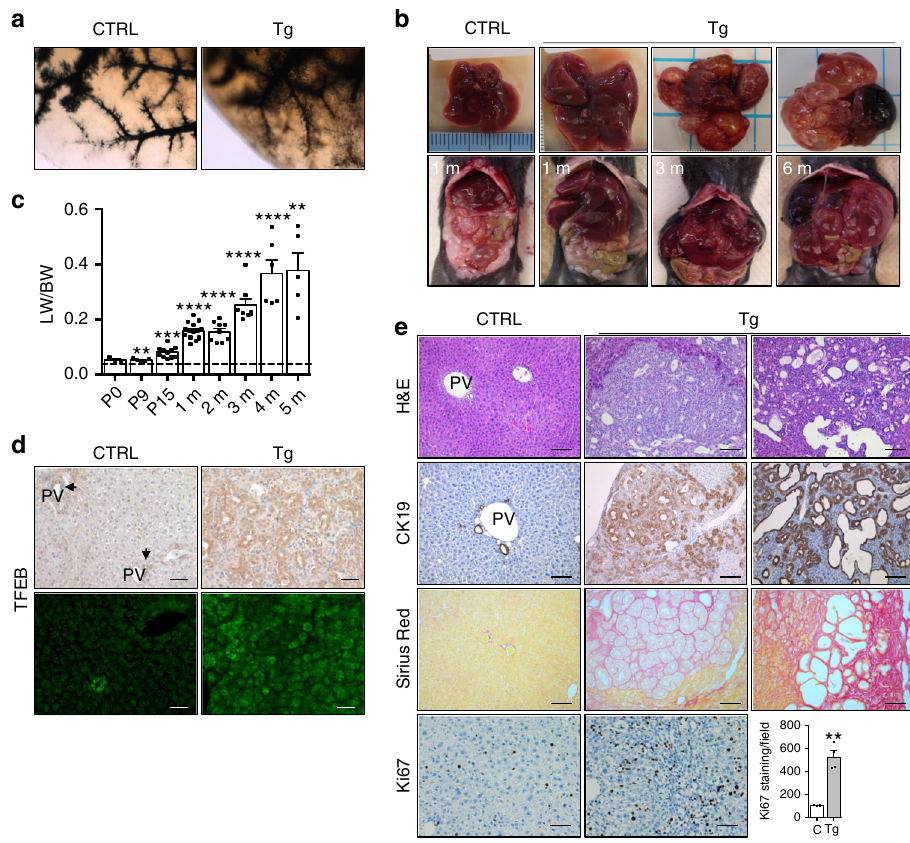
Fig. 8 Bile duct neoplasm in TFEB-overexpressing liver. a Retrograde injection of ink revealed abnormal development of the bile duct in Tg liver compared to control. b Gross appearance of livers in Tg mice at several ages. c Quanti fi cation of liver-to-body weight ratio (LW/BW) in Tg mice at the indicated age. ( n = 3 P0, n = 5 P9, n = 11 P15, n = 15 1 month, n = 9 2 months, n = 8 3 months, n = 6 4 months, n = 5 5 months). Values were normalized to age-matched control liver as indicated by the dashed line. d Immunohistochemistry and in situ hybridization analysis for TFEB in CTRL and Tg liver at 3 months of age. Scale bar 50 μ m. e Histological characterization of Tg liver phenotype at 3 months of age. Lower panel: Ki67 staining and relative quanti fi cation showing increased cell proliferation in Tg liver compared to CTRL (CTRL n = 3, Tg n = 4 biological replicates/ n = 5 different images/sample). Data are represented as mean ± SEM. *** p ≤ 0.001, **** p ≤ 0.0001 two-tailed Student ’ s t -test. Scale bar 100 μ m. Source data are provided as a Source Data fi